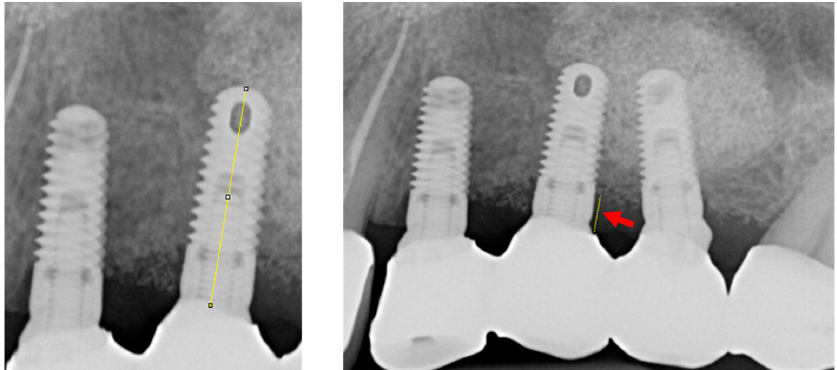
Figure 1. Measurement of peri-implant bone levels from representative intraoral radiographs. The known implant diameter length from implant-abutment interface to the apex was used for calibration (left panel). Then, the distance between the implant-abutment interface and the most apical point of crestal bone observed to be in intimate contact with the implant was measured (right panel). Accuracy of measurements was 0.01 mm. Marginal bone loss (MBL) for each implant at a given time-point was calculated by subtracting the peri-implant bone level at that time point to peri-implant bone level at implant insertion.